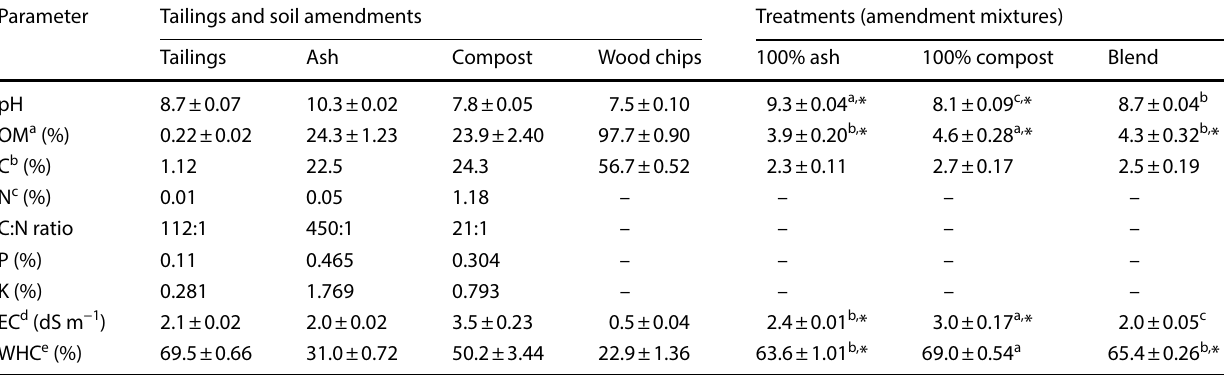
Table 2 Select physiochemical parameters of mine tailings, organic amendments, and amendment mixtures